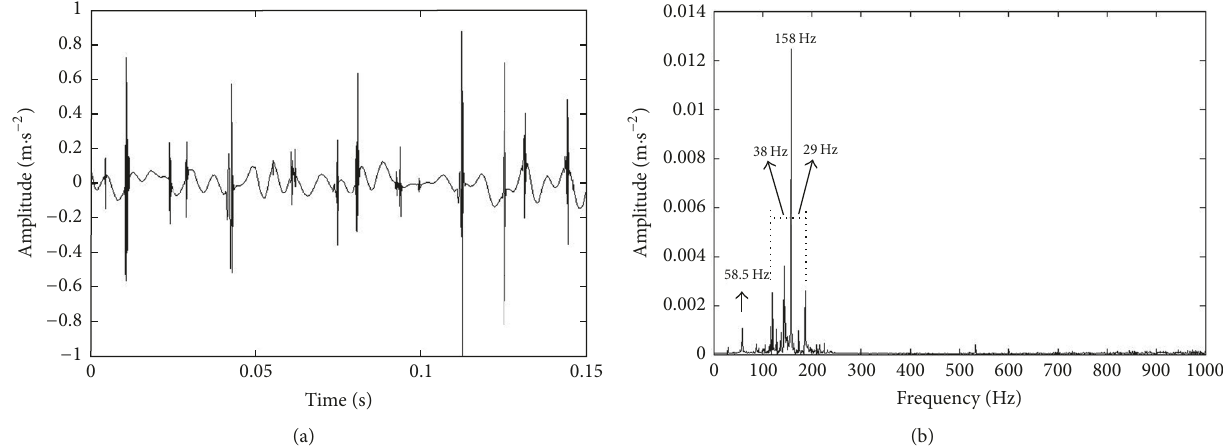
Figure 4: Denoising by soft thresholding technique: (a) waveform in the time domain; (b) frequency spectrum.